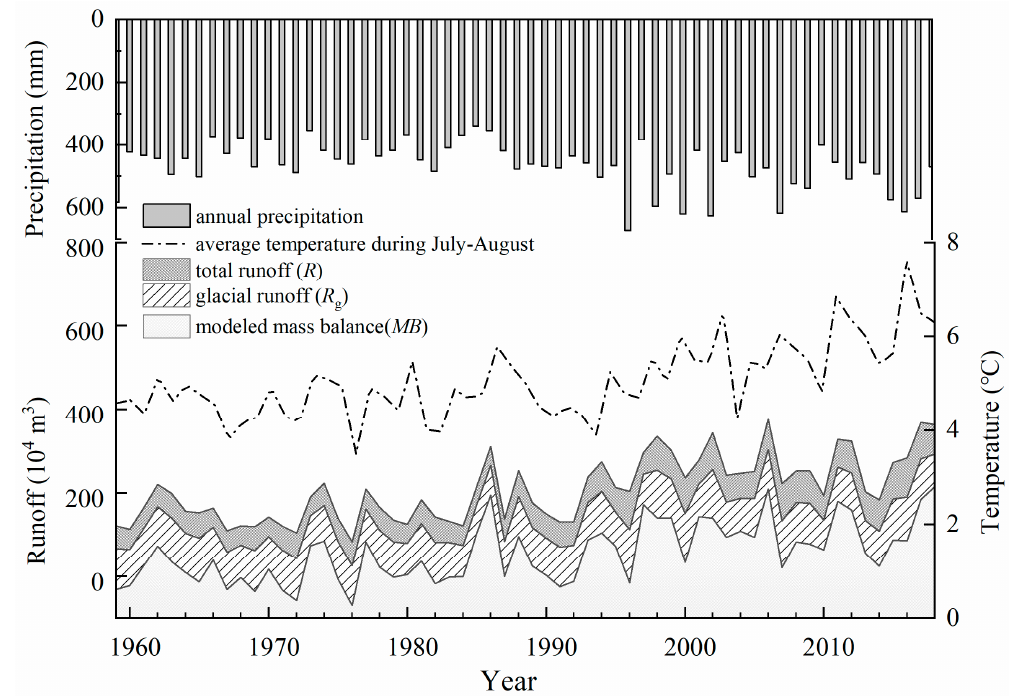
Figure 4. Variations of annual precipitation, temperature (average of July–August), total runoff ( R ), glacial runoff ( R g ) and glacier mass balance ( MB ) at the Urumqi Glacier No. 1 hydrometeorological station (UG1HMS) from 1959 to 2018.